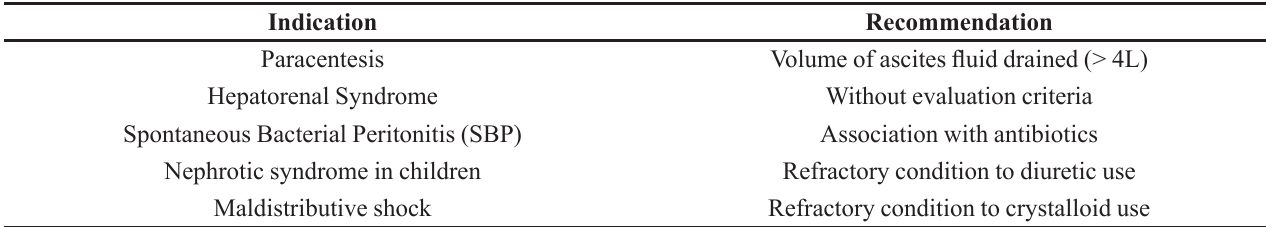
TABLE VI - Conditions for the use of HA according to other clinical